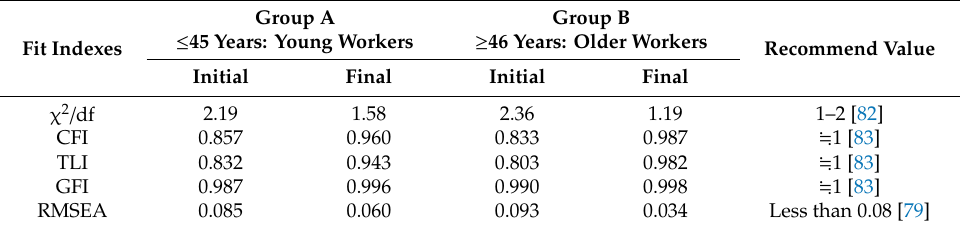
Table 8. The validity indicator of Group A’s and Group B’s models, and recommended